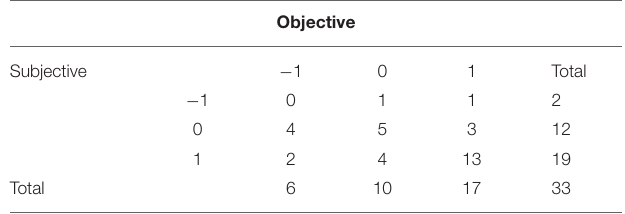
TABLE 4 | Subjective vs. objective data